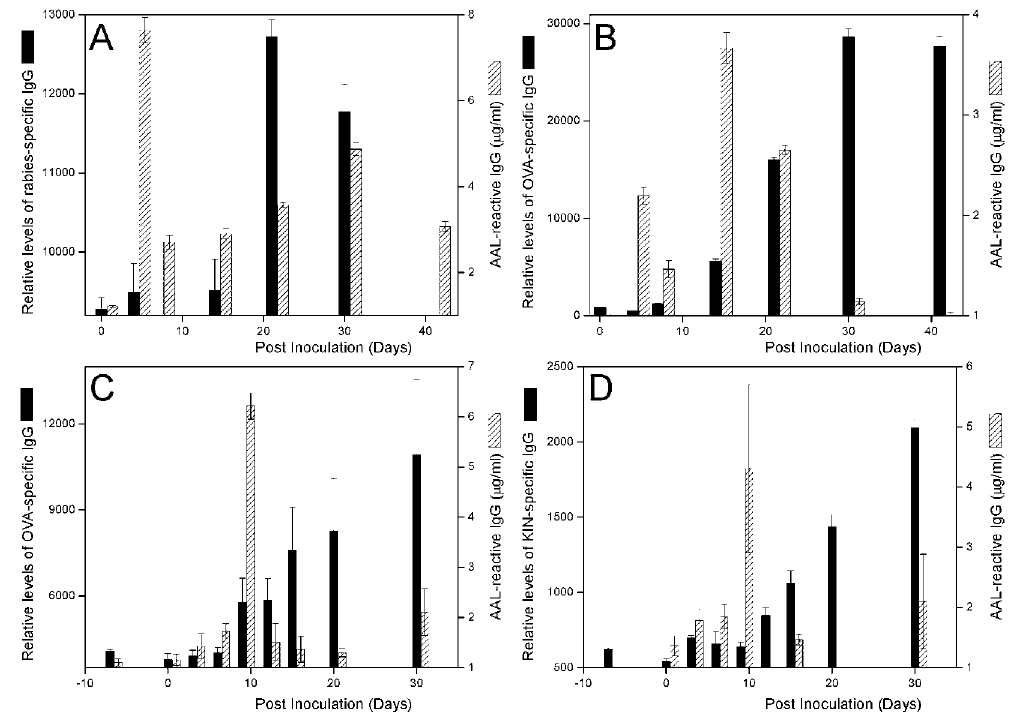
Figure 3. Production kinetics of AAL-reactive IgG and immunogen specific IgG production in immunized mice and rabbits measured by using AAL-antibody microarrays. Different animals were immunized with different immunogens as shown in Table 1. Both immunogen specific IgG and AAL-reactive IgG were measured in the serum samples from each animal. The black bar in the graphs showed averaged immunogen-specific IgG level (relative levels according to the fluorescence intensities); and the strip bars in the graphs showed averaged AAL- reactive IgG levels. (A) Five mice (strain C57BL/6) were inoculated with inactivated rabies virus; (B) Five mice (strain C57BL/6) were inoculated with OVA/CFA; (C) Two rabbits were inoculated with OVA/CFA, (D) Two rabbits were inoculated with